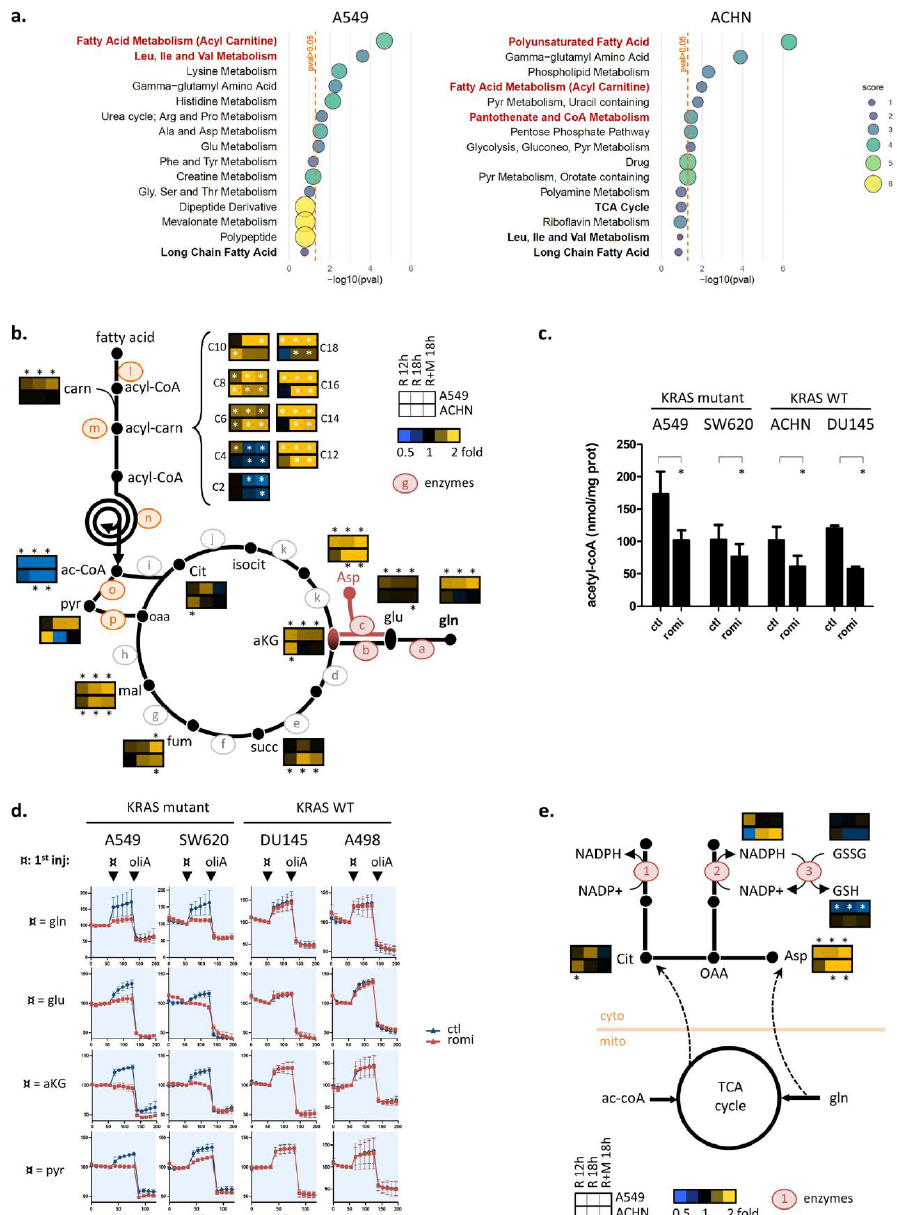
Figure 4. Romidepsin affects acetyl-CoA availability ( a ) 620 metabolites were quantified in A549 and ACHN cell lines after 18 h romidepsin treatment (clinical dosing), and the top 15 enriched metabolic pathways were obtained after enrichment pathway analysis on significantly modified com- pounds (Welsh’s t -test). p -values for pathway scores were calculated using hypergeometric test. ( b ) 620 metabolites were quantified after treatment with romidepsin (clinical dosing) for 12 h, 18 h and 18 h in combination with MEKi, and those involved in β -oxidation, glutaminolysis and TCA cycle were overlaid on TCA cycle fueling pathway representation (median fold change). Letters refer to enzymes whom expression was quantified by microarray analysis, and for which results are pre- sented in Supplementary Figure S5c. Statistical difference between control and treated groups was